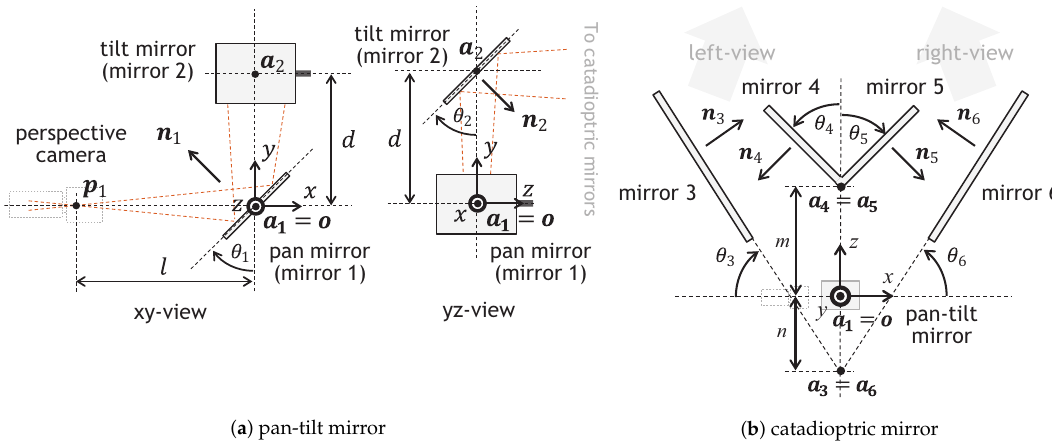
Figure 4. Geometries of the pan-tilt mirror system and the catadioptric mirror system: ( a ) pan-tilt mirror; ( b ) catadioptric